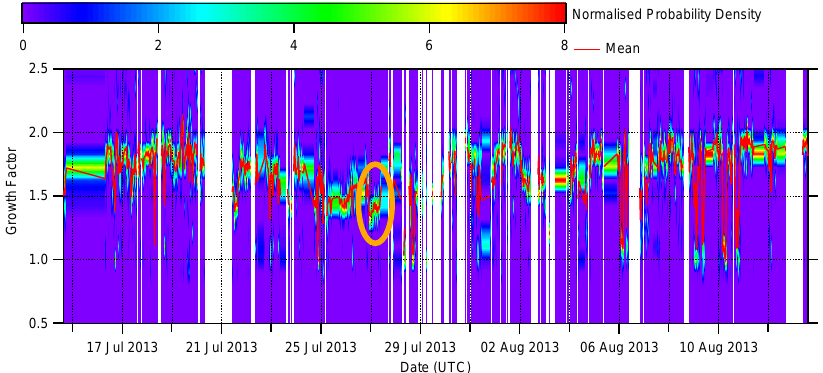
Figure 6. HTDMA-derived growth factor probability distribution functions for 50nm dry particles at 90% relative humidity, with associated mean growth factors. The low growth factors associated with the case study time period (26 July, 22:50–23:45UTC) are